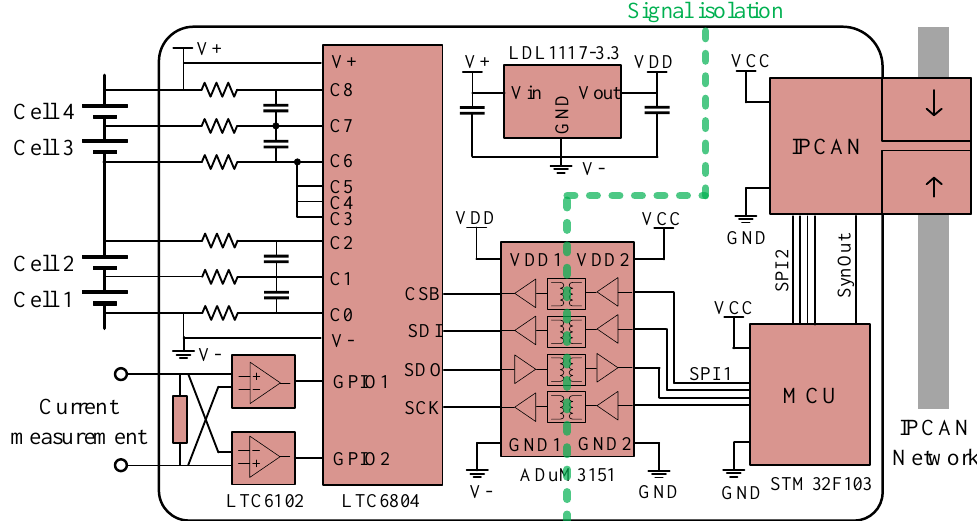
Figure 3. The schematic diagram of the monitor node for lithium-ion battery pack.